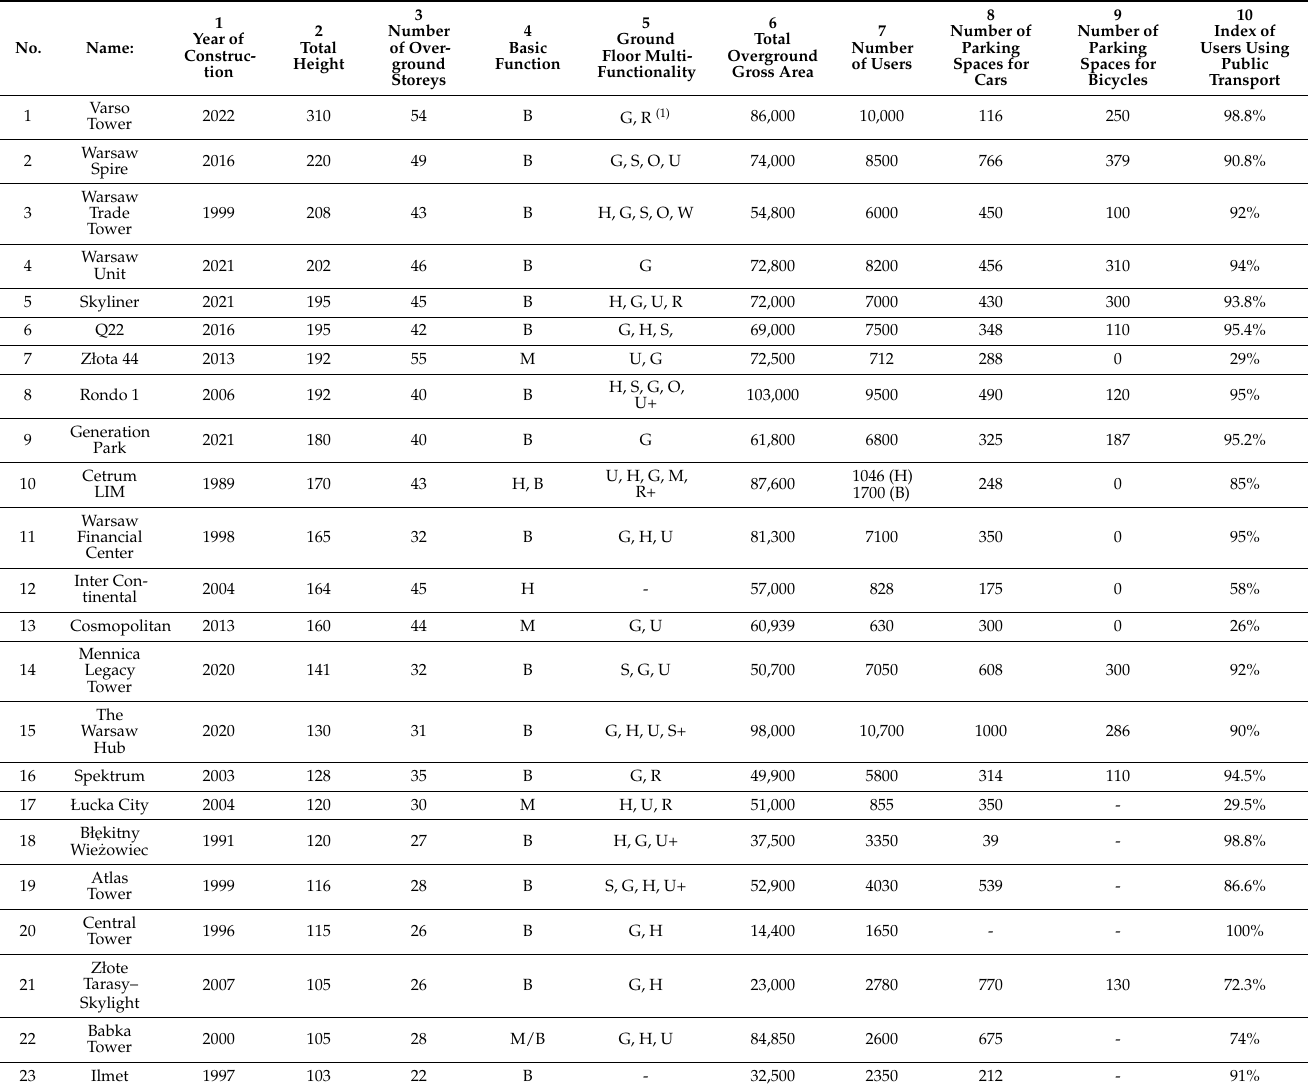
Table 1. Research in terms of function criteria and traffic generation in public space. Legend: 1—Year of construction. 2—Total height (m). 3—Number of overground storeys. 4—Basic function: office (B), residential (M), hotel (H). 5—Ground floor multi-functionality: commercial (H), gastronomic (G), service (U), medical (M), sports (S), wellness (W), entertainment (R), educational (O).